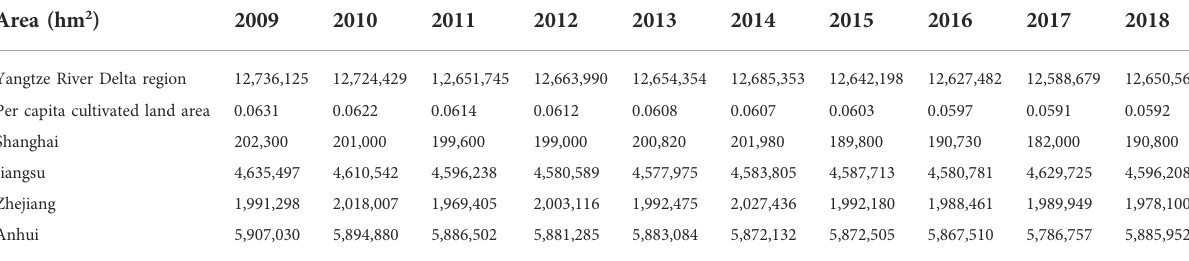
TABLE 1 Cultivated land area in the Yangtze River Delta from 2009 to 2018.